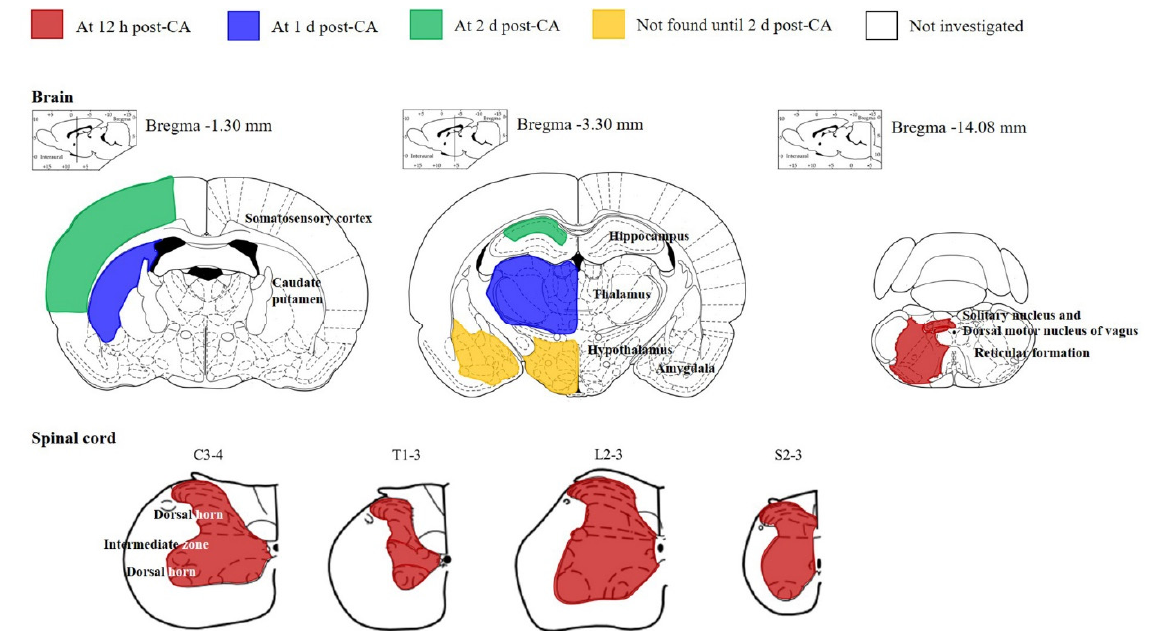
Figure 7. Schematic drawings of neuronal damage/death in brain and spinal cord regions related to autonomic control in the rat. Neuronal death at 12 h, 1 day and 2 days post-CA is marked by red, blue and green, respectively. Yellow indicates that neuronal death is not shown until 2 days post-CA, and white indicates that we did not investigate neuronal death after CA. Generally, the earliest neuronal death occurs in the myelencephalon and spinal cord.